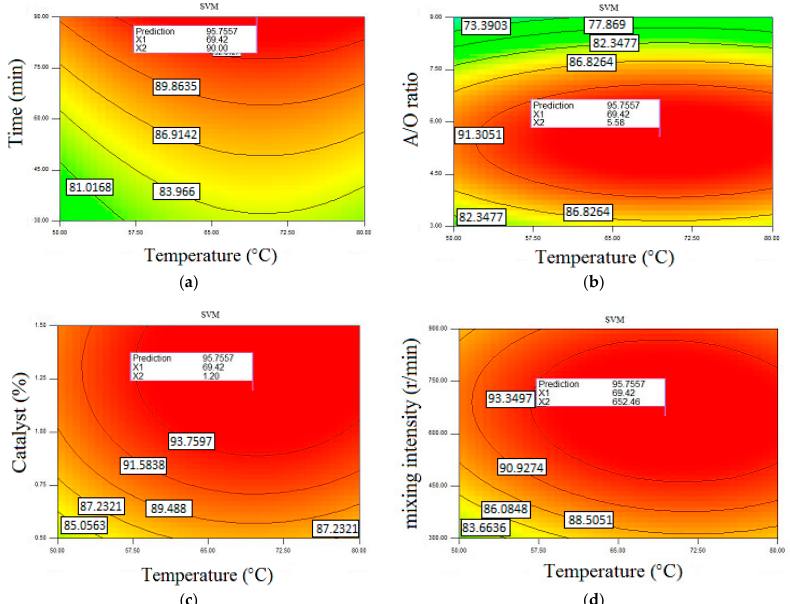
Figure 10. The optimization condition of ethyl ester production in the case of using the RSM-SVM method. ( a ) Response surface based on time (min) and temperature (°C); ( b ) response surface based on A/O and temperature (°C); ( c ) response surface based on catalyst (wt. %) ratio and temperature (°C); and ( d ) response surface based on mixing intensity (r/min) and temperature (°C).